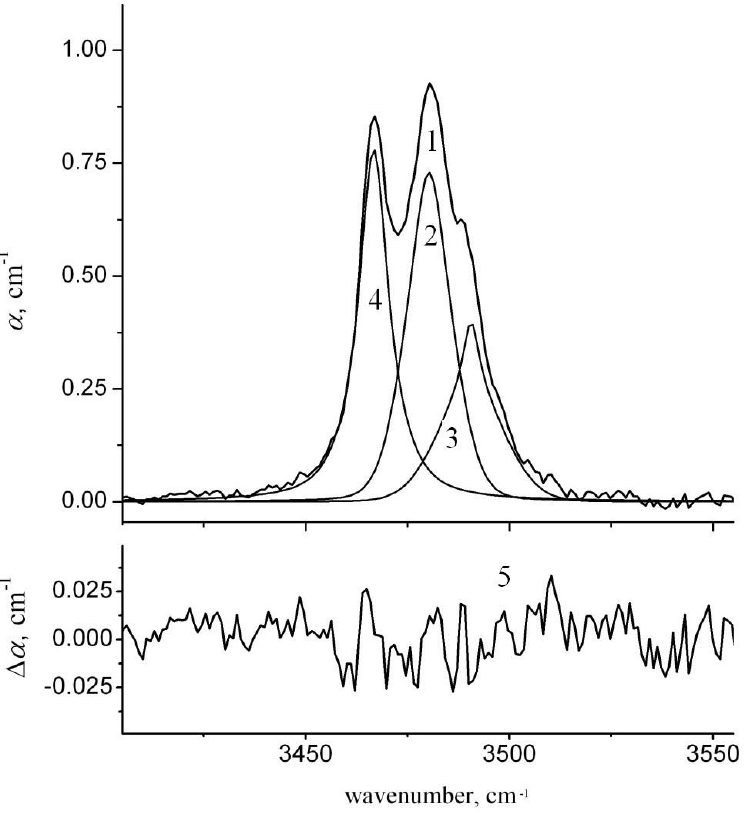
Figure 6. IR spectrum of NSLN1: (1) integrated IR absorption spectrum of the NSLN1 sample; (2) – (4) spectrum components; and (5) difference function Δα.